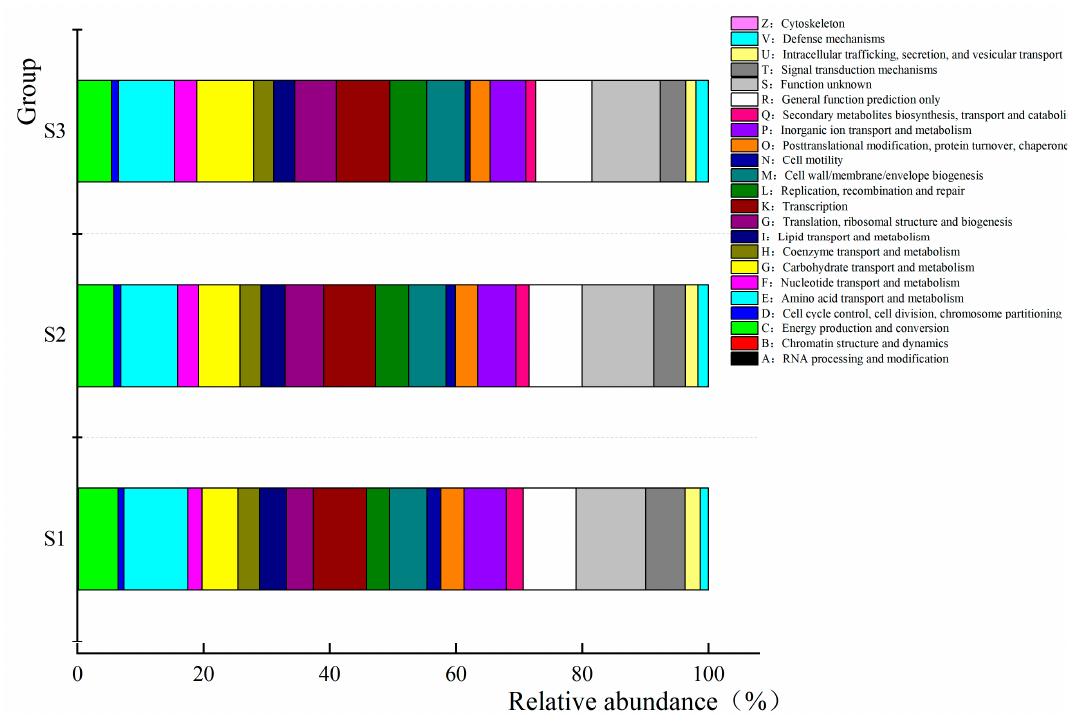
Figure 7. Analysis of bacterial COG functional enrichment.